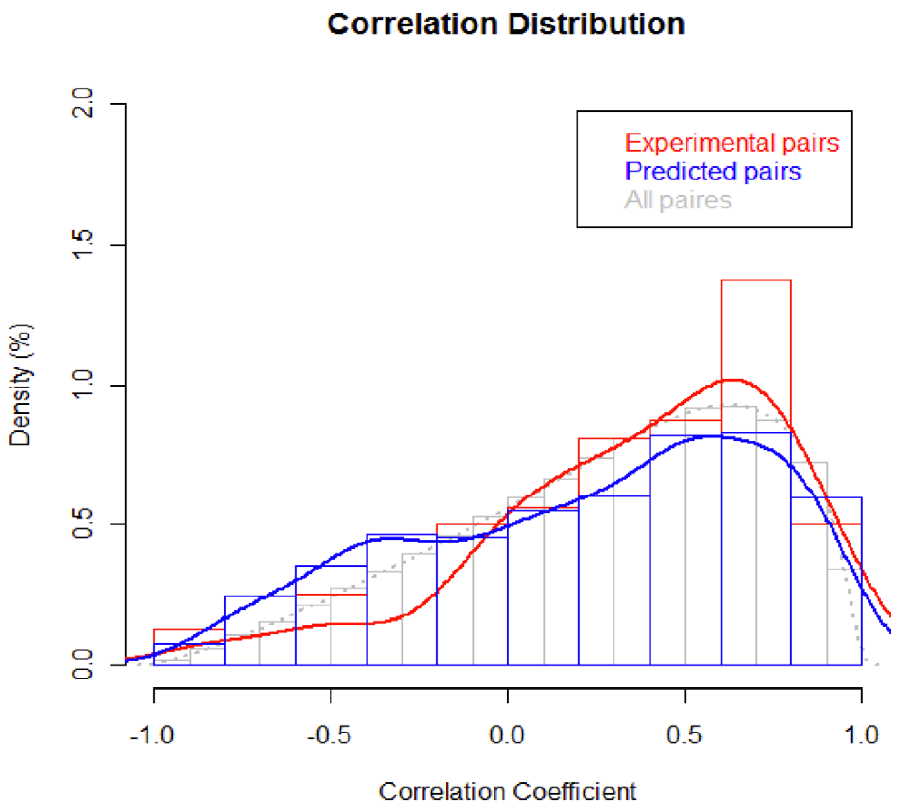
Figure 3. Distribution of the correlation coefficients between microRNA and mRNA targets. (The blue plot represents the predicted microRNA/mRNA pairs and the red plot represents the experimental validated pairs; the background plot in gray represents all pairs used for analysis in this study).